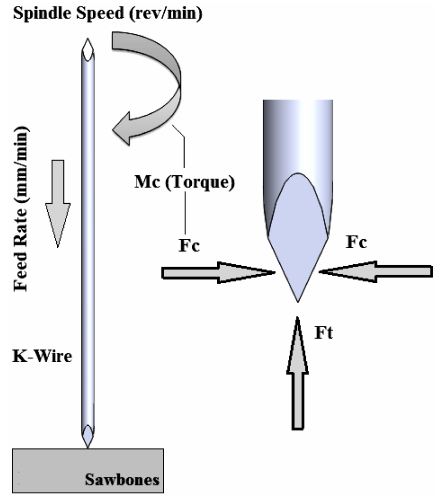
Figure 1. The drilling operation with K-wire and the forces occur-